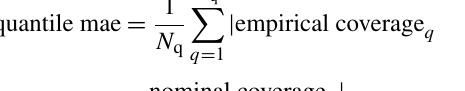
Table 1. Turbine subsets, number of valid forecasts considered and crps (% of the subsets’ rated power) for the vine, empirical and exponential copula approach and persistence for unstable and stable atmospheric conditions. The lowest scores are shown in bold.